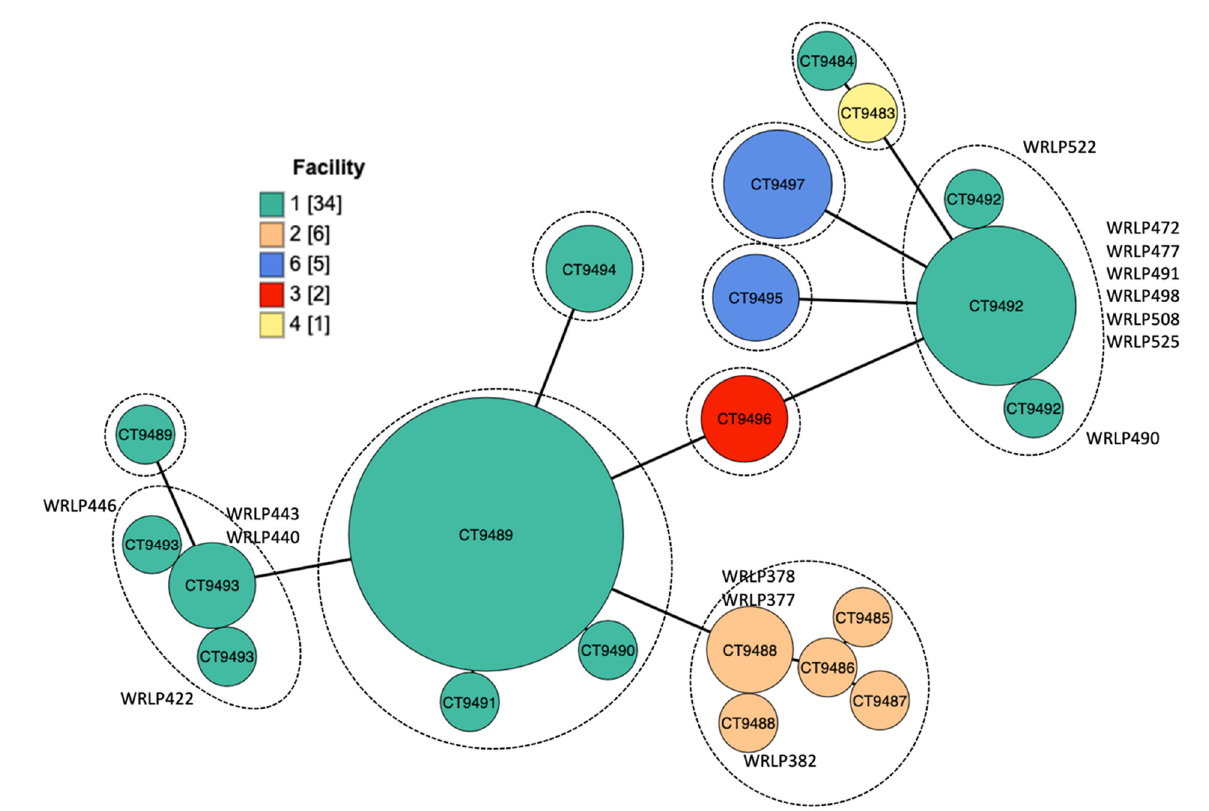
Figure 1. Minimum spanning tree of core genome MLST (cgMLST) profiles. Unique profiles are represented by nodes, the size of each node reflects the number of isolates that share an identical cgMLST profile. CT represented by different nodes have up to seven allelic differences. Colors are representative of the facility number from which the isolate was found. The length of the branch between nodes is proportional to the number of allelic differences between profiles. The dashed circles groupings of the nodes represent the sublineages which have up to 150 allelic differences.